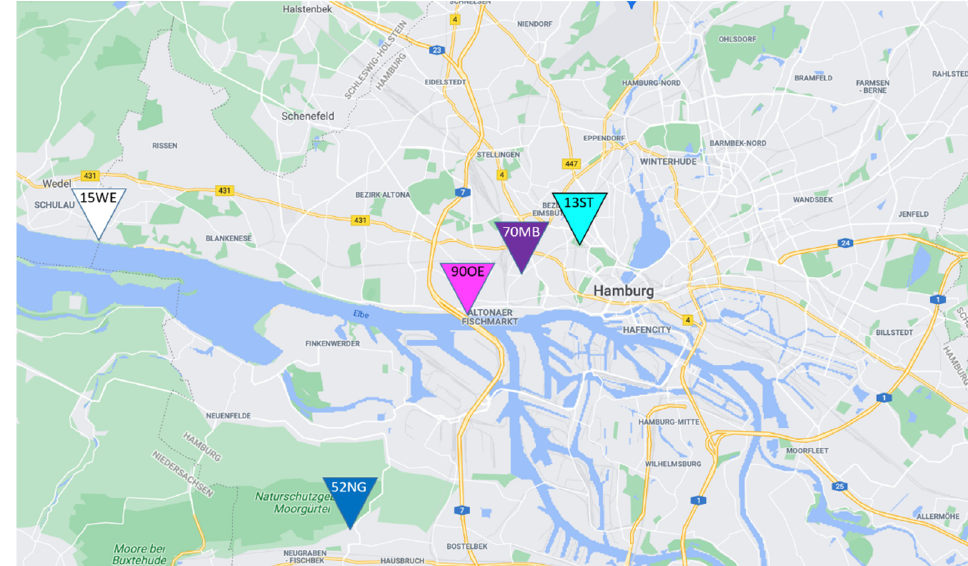
Figure 3. Map of Hamburg with overview of measurement locations. Dark blue: suburban back- ground (Neugraben, 52NG); cyan: urban background (Sternschanze, 13ST); purple: road traffic (Max-Brauer Allee, 70MB); magenta: ferryboat pier (Övelgönne, 90OE); white: background/shipping traffic (location of the measurement data for the background concentration; Wedel, 15WE). The motorway visible on the map right next to the pier is tunneled. The marking in Wedel (15WE) shows the location of constant PN monitoring by BSH that was used for the definition of the constant back- ground concentration.